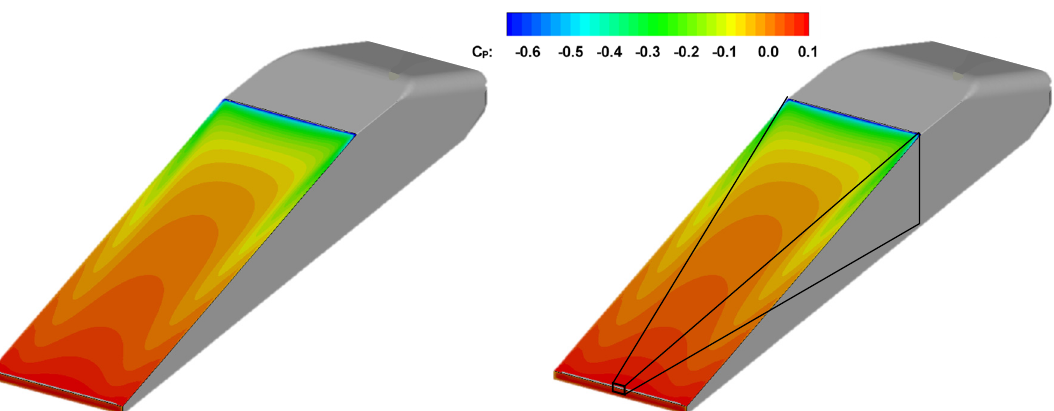
Figure 7. Pressure distribution on the slant surface of the Windsor body with a long tail, (left) and with the side taper geometry superimposed, (right).